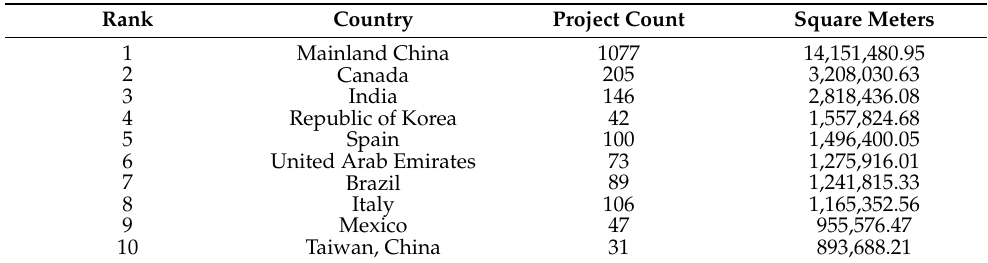
Table 1. Top 10 Countries making profound progress in constructing sustainable buildings, according to the USGBC [46]. Rank Country Project Count Square